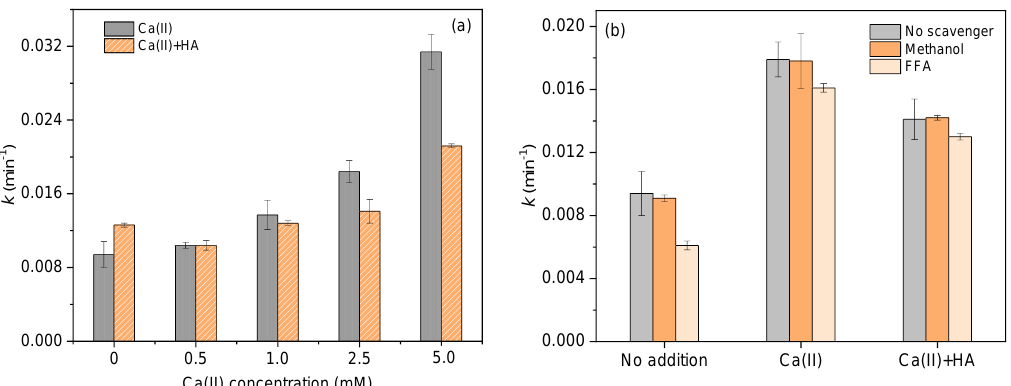
Figure 2. The rate constants of TC in the presence of Ca(II) and humic acid (HA)-Ca(II) complex with ( a ) and without ( b ) scavengers.